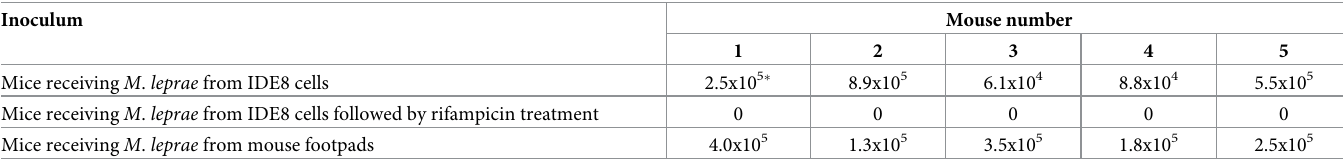
Table 1. Viability of tick cell-derived Mycobacterium leprae in the Shepard model. Inoculum Mice receiving M . leprae from IDE8 cells Mice receiving M . leprae from IDE8 cells followed by rifampicin treatment Mice receiving M . leprae from mouse footpads